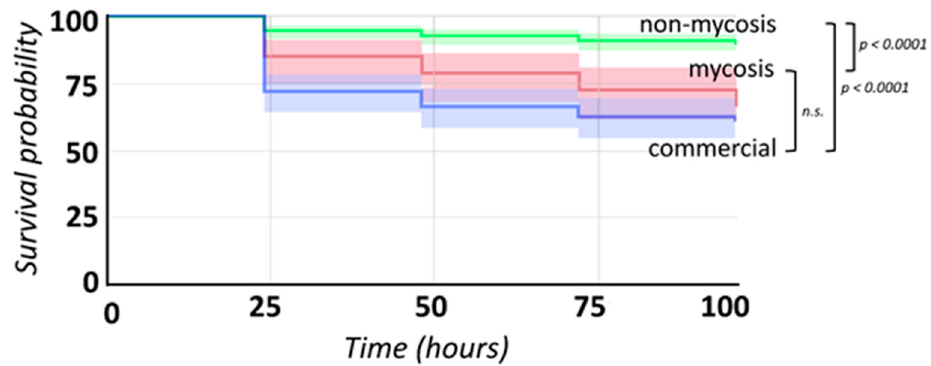
Figure 5. Survival curves of Galleria larvae inoculated with members of the commercial, non-mycosis, and mycosis sample groups. Significance of differences between groups is indicated on the right, based on Kaplan–Meier analysis, n.s. indicates that the difference is not significant. Shaded areas represent 95% log confidence interval.